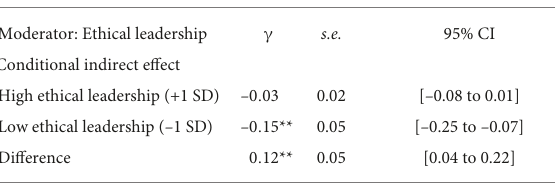
TABLE 4 Result of moderated mediating effect of ethical